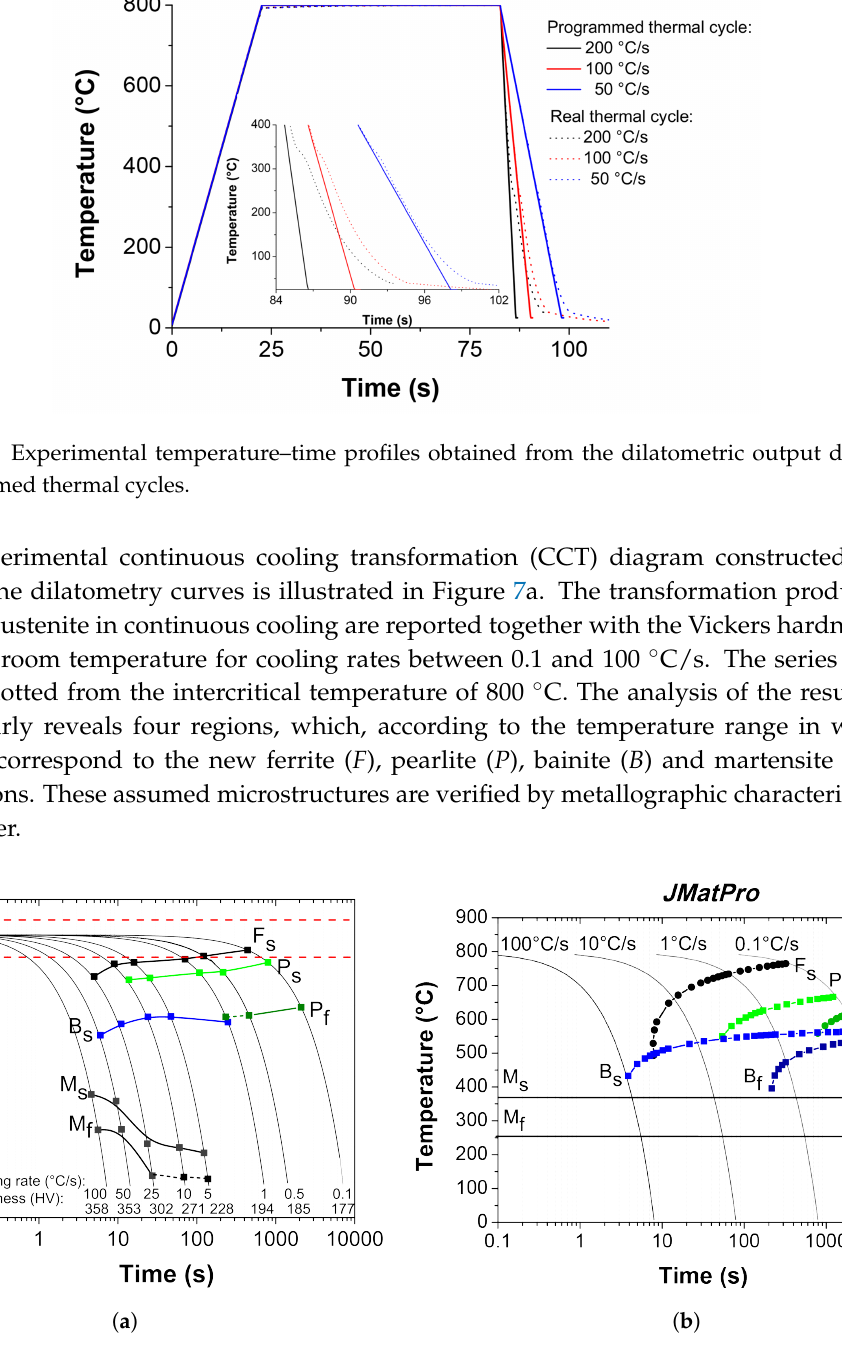
Figure 7. ( a ) Experimental continuous cooling transformation (CCT) diagram determined from the analysis of the dilatometry curves in continuous cooling from the intercritical region of 800 ◦ C; ( b ) theoretical CCT diagram calculated by using JMatPro